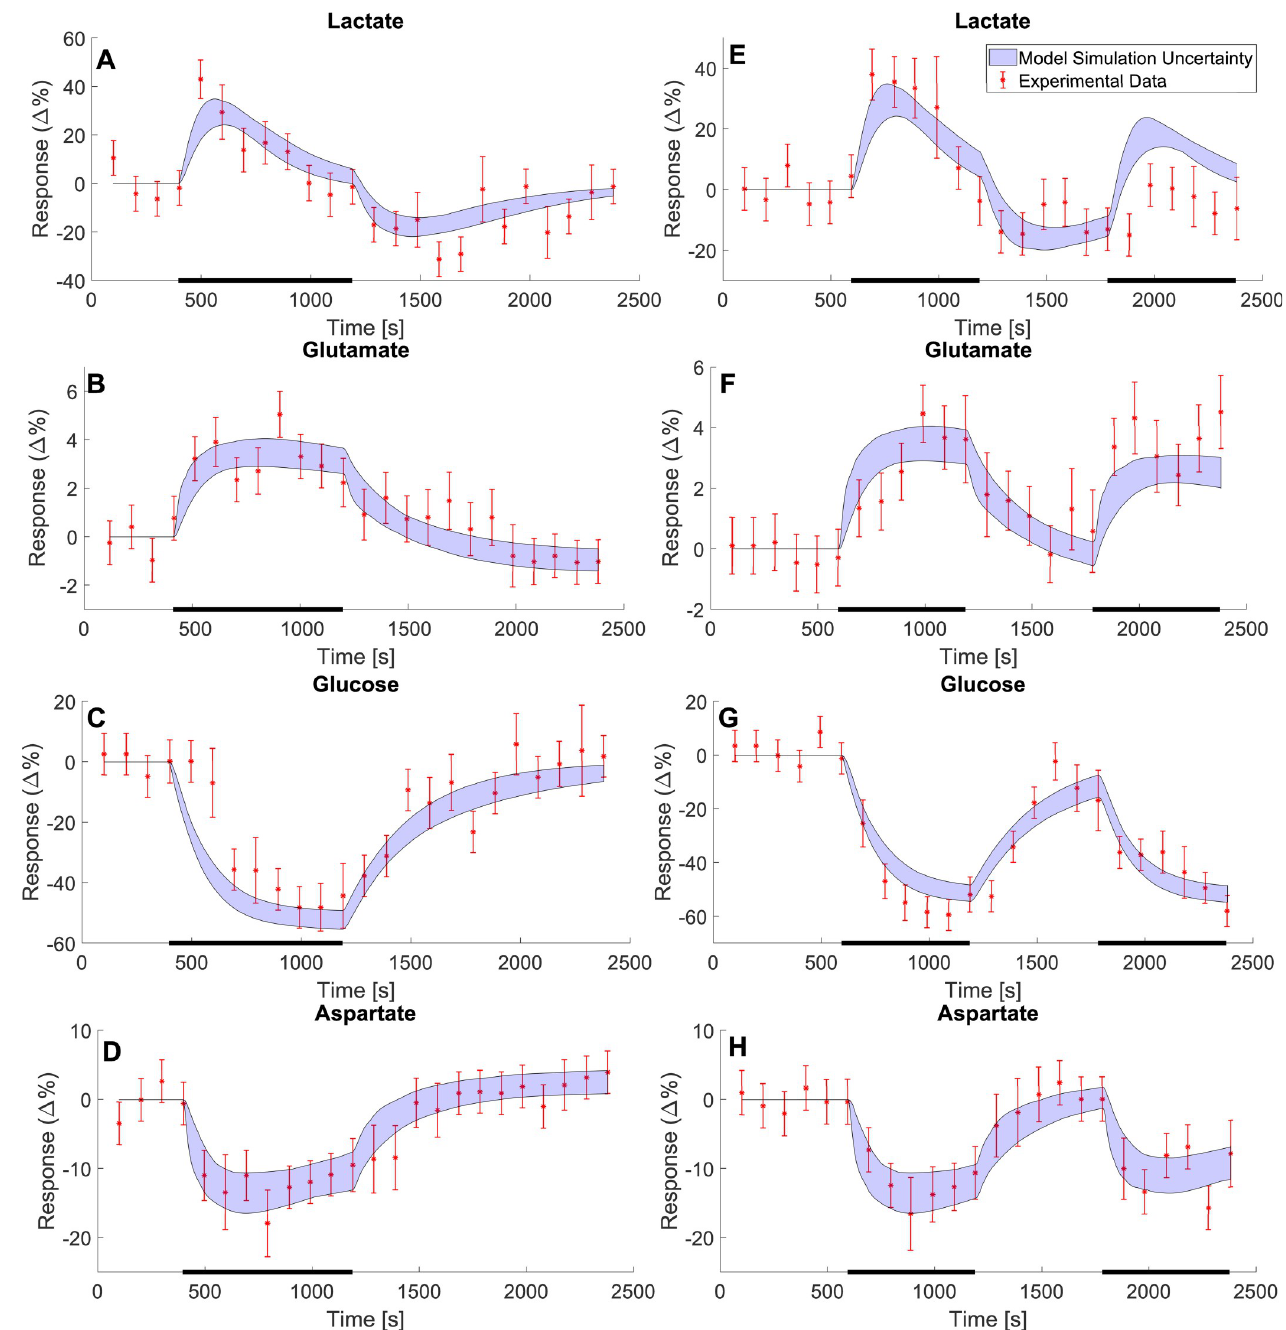
Fig 2. Model estimation to MRS data showing changes in metabolic concentrations following visual stimuli. The data gathered from Lin et al. 2012 [34] shows the change in metabolic concentrations as a response to two different visual stimulus paradigms. The first paradigm (A-D) consisted of a single visual stimulus lasting for 13.6 minutes, indicated by the black bar at the bottom of the plots. The second paradigm (E-H) consists of two 9.9-minute periods of stimulus, separated by a 9.9-minute rest period for each. For both stimulation paradigms four metabolites were analysed: lactate (A and E), glutamate (B and F), glucose (C and G), and aspartate (D and H). The data is here illustrated as a relative change from a baseline, with a mean value ± SEM (red error bars). The model estimation is illustrated as the blue shaded areas.